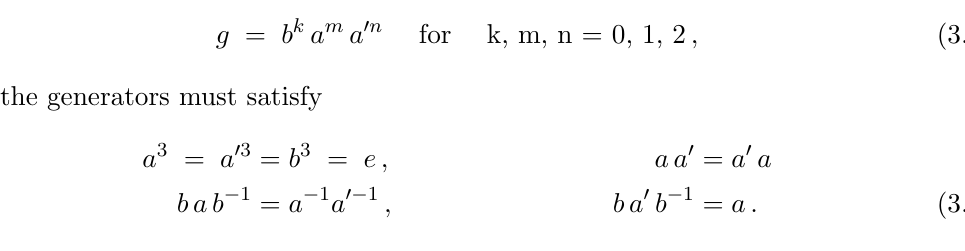
(cid:2) Z 0 ) n Z . The elements 3 N N ( a , a 0 , b ) as 3